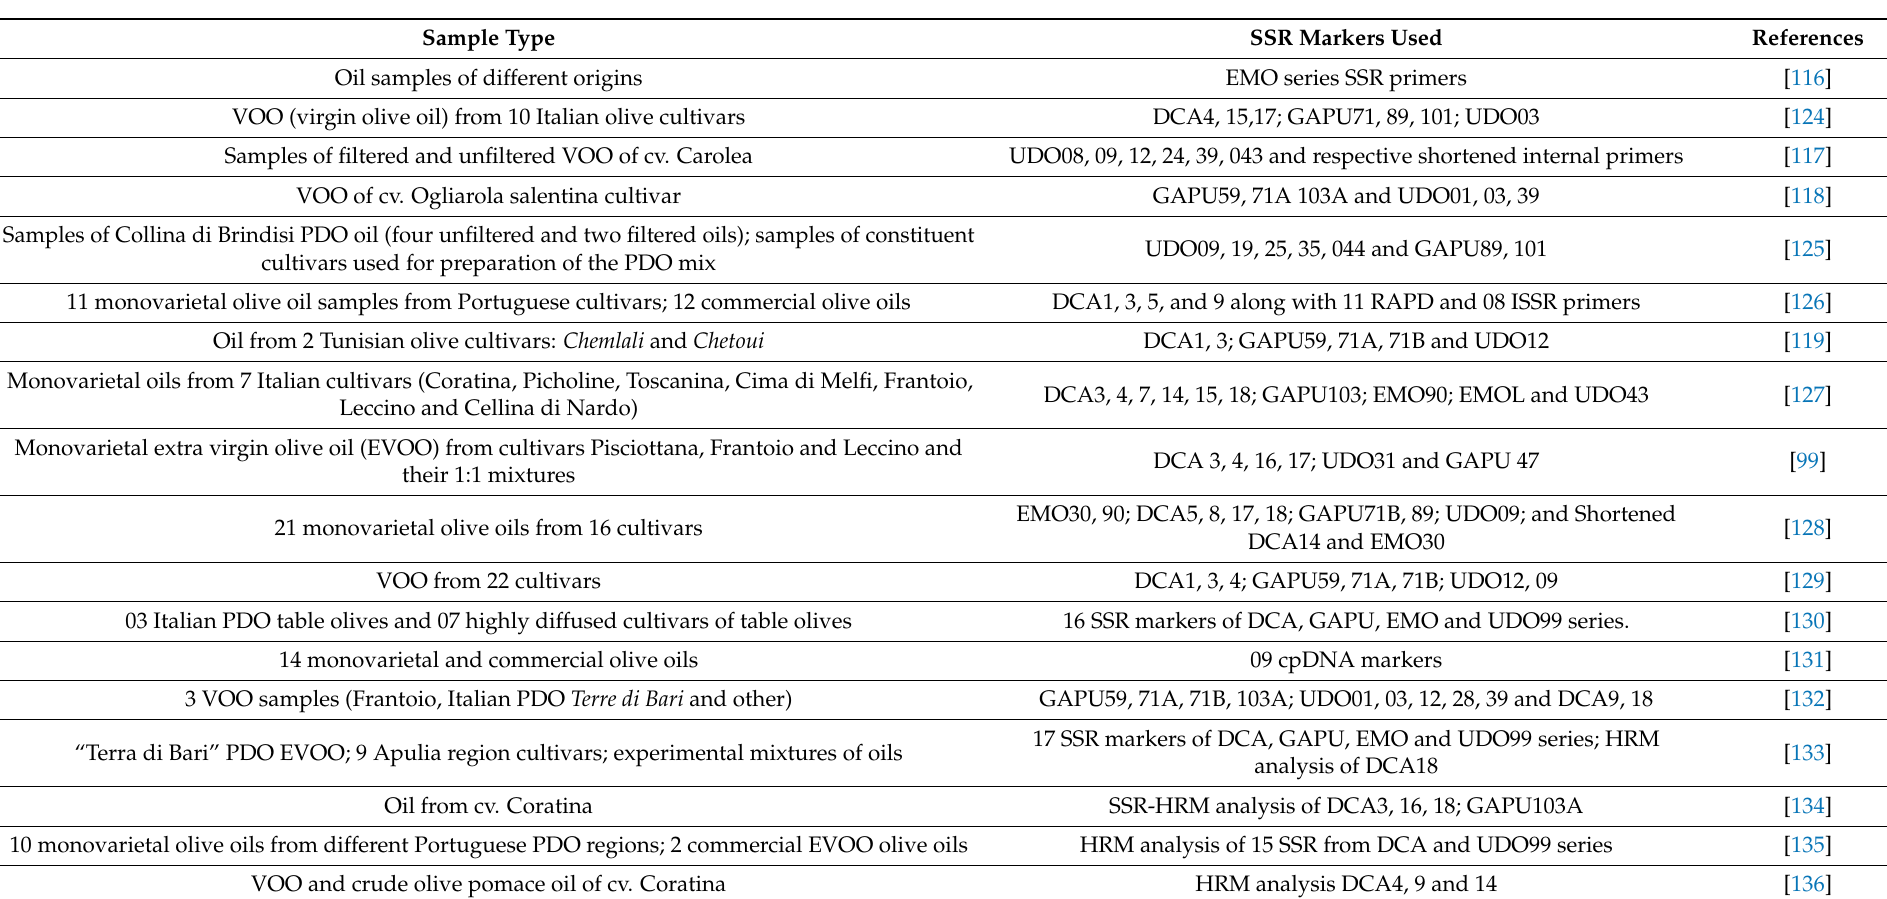
Table 3. Applications of microsatellites in olive oil and table olive